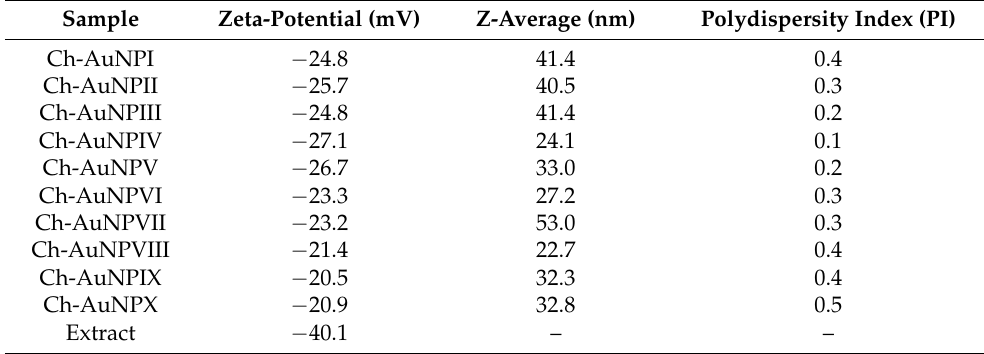
Table 1. DLS analysis of Ch-AuNPs and